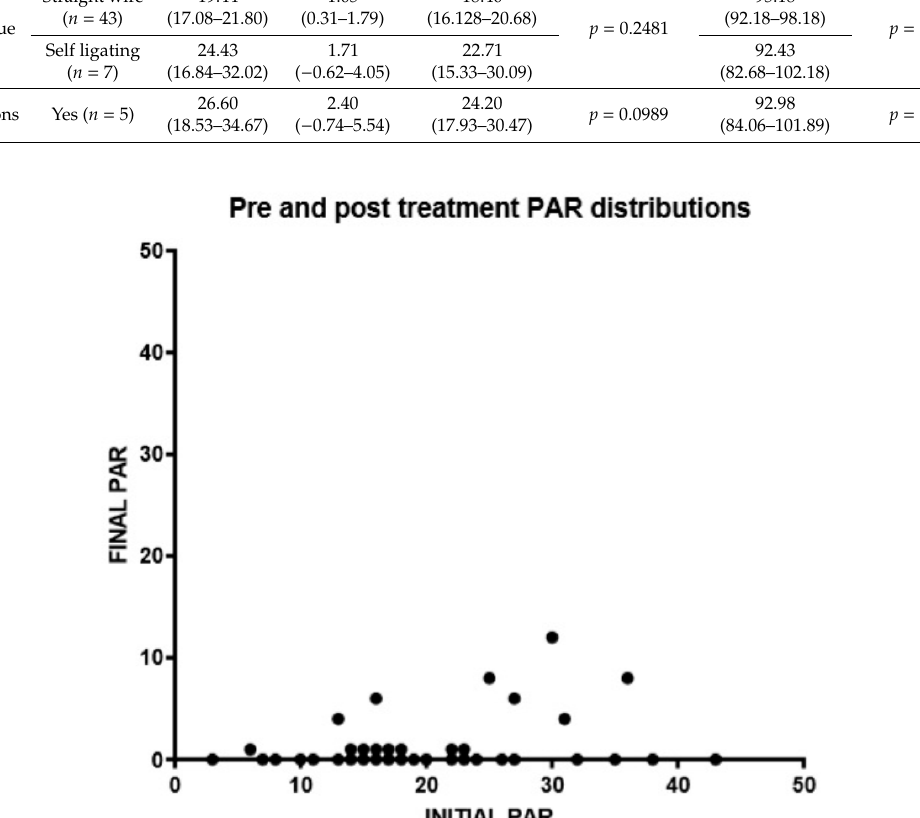
Figure 9. Relation between pre-treatment and post-treatment PAR